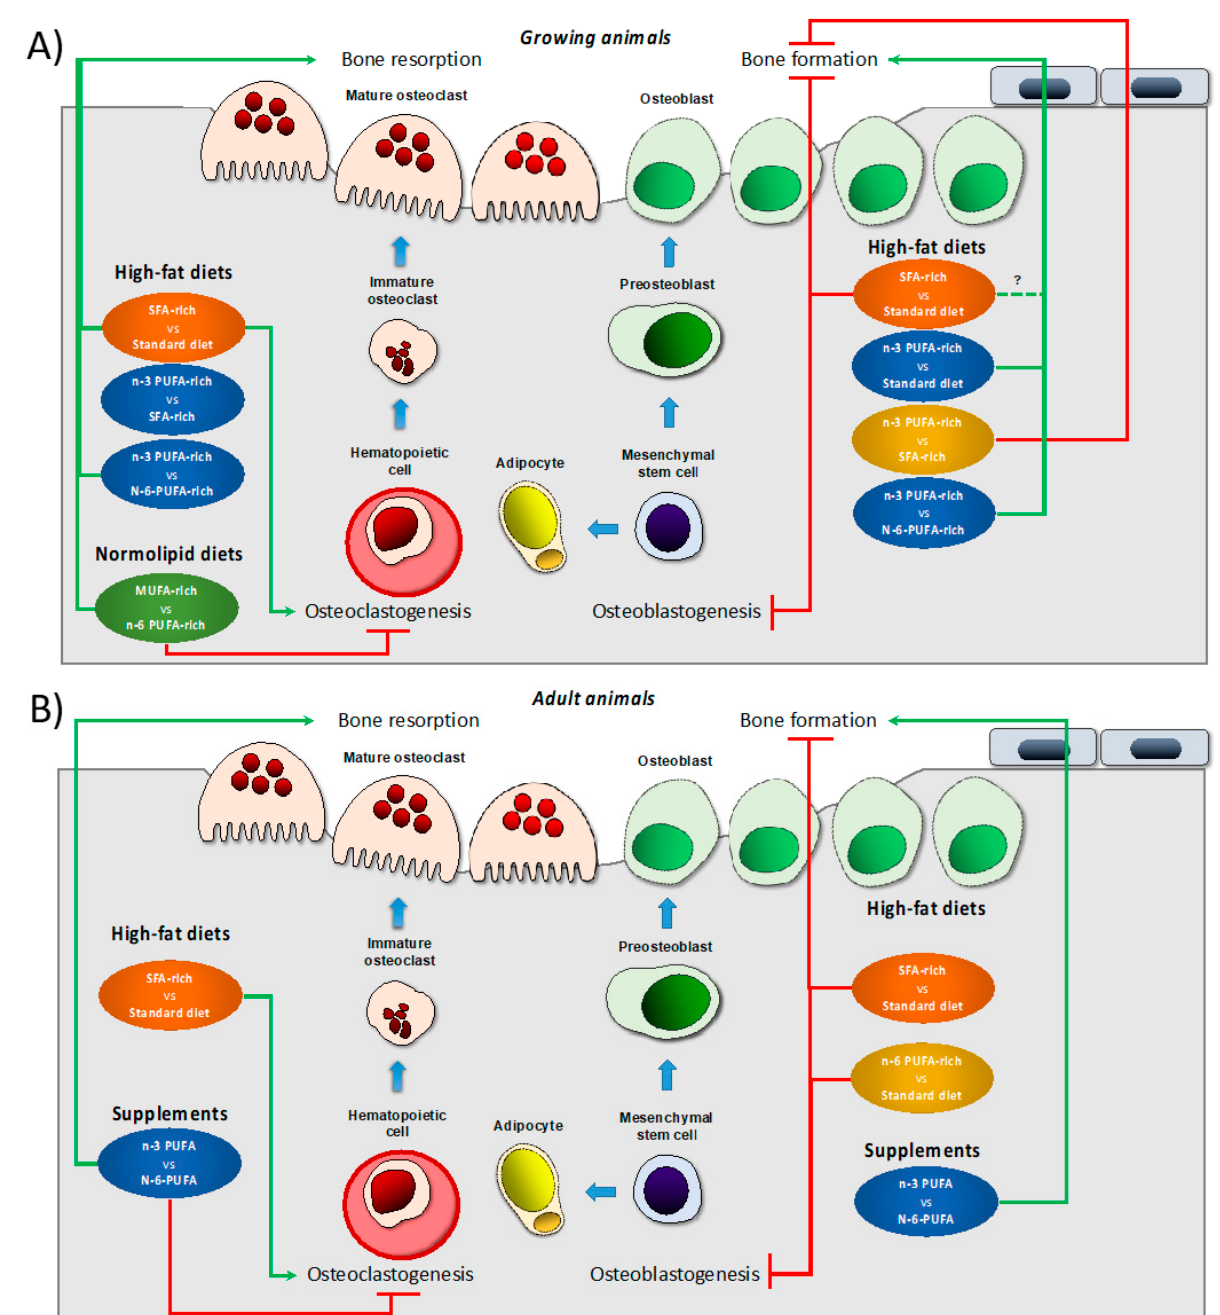
Figure 1. Effect of different dietary interventions concerning dietary fat on bone biology and metabolism reported in growing ( A ) or adult ( B ) animal models. The effects refer changes respect than control diet (indicated after the term vs. in any case) which depend on each study design. Dietary interventions have been subdivided in two categories, high fat diet that, in turn, can be rich in different fat types or supplements with specifical fat types. Green arrows indicate induction in the particular process. Red truncated lines indicate a decrease in the particular process. Abbreviations: MUFA: monounsaturated fatty acids; n-3 PUFA: n-3 polyunsaturated fatty acids; n-6 polyunsaturated fatty acids; SFA: saturated fatty acids, vs.: